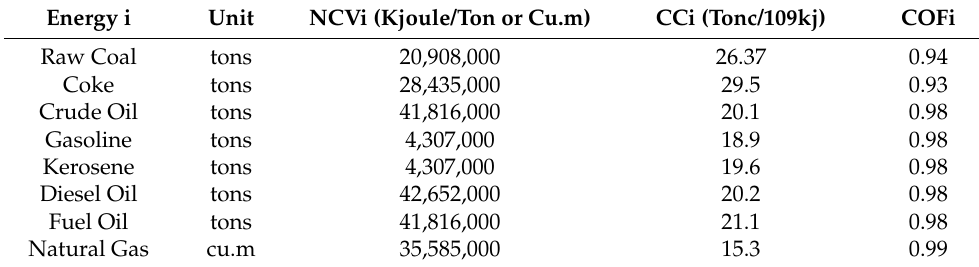
Table 1. The energy supply